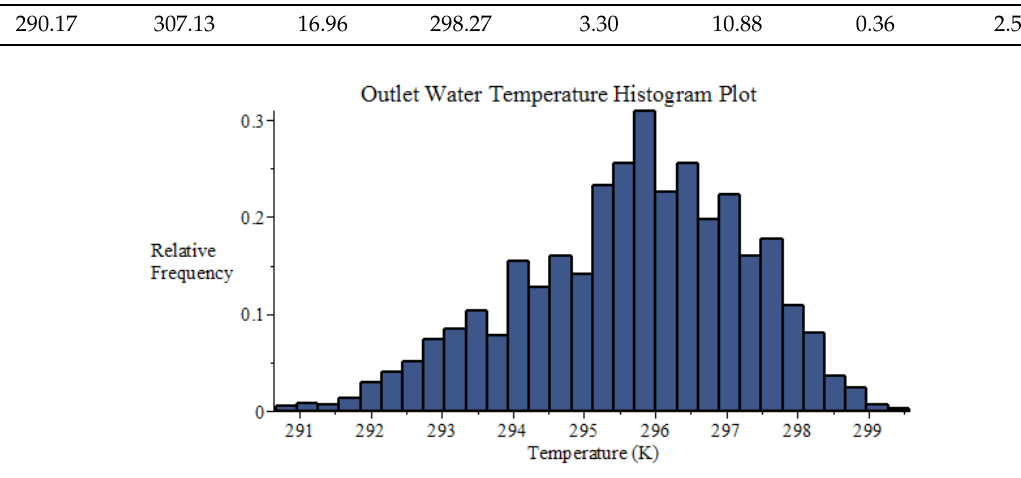
Figure A5. Histogram plot of water outlet temperature measurements, within the 7688 data sets collected by SRNL from F-Area cooling towers (unsaturated conditions).